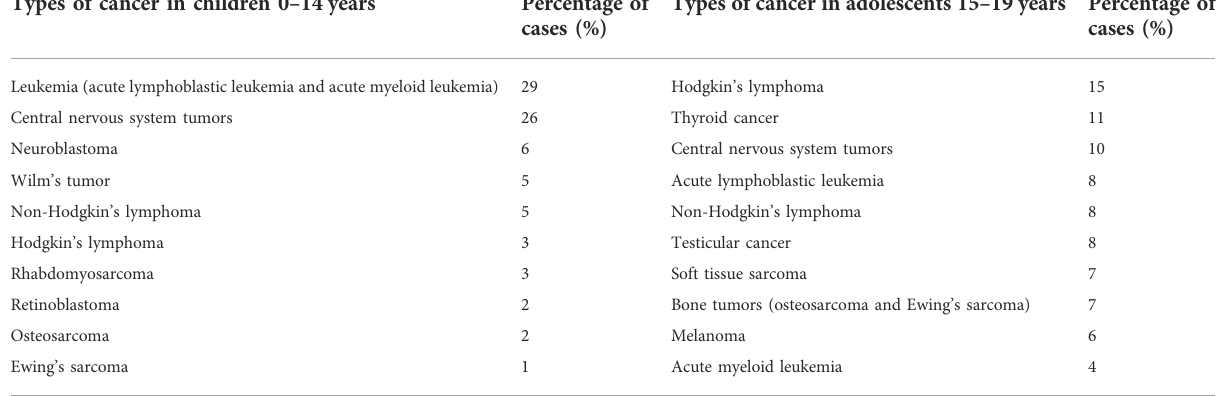
TABLE 1 Common types of cancer arising in children and adolescents (Siegel et al., 2022). Types of cancer in children 0 – 14